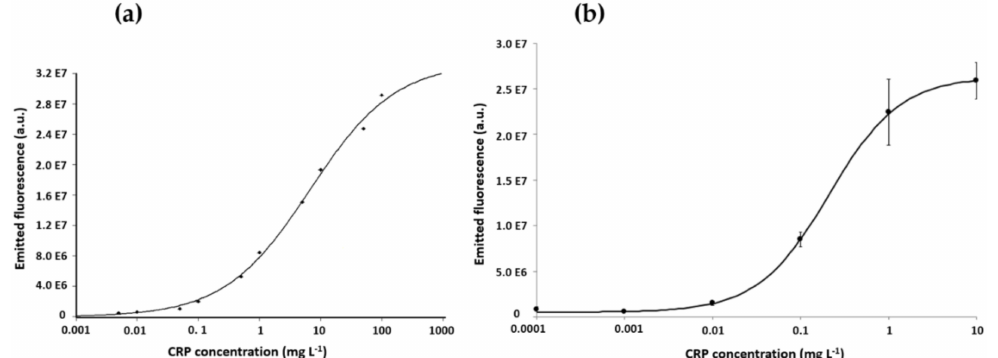
Figure 6. ( a ) Calibration curve for CRP (from 5 µ g L − 1 up to 100 mg L − 1 ) in PBS bu ff er; ( b ) calibration curve for CRP (from 0.1 µ g L − 1 up to 10 mg L − 1 ) spiked in 1:10-diluted serum (modified from figures in